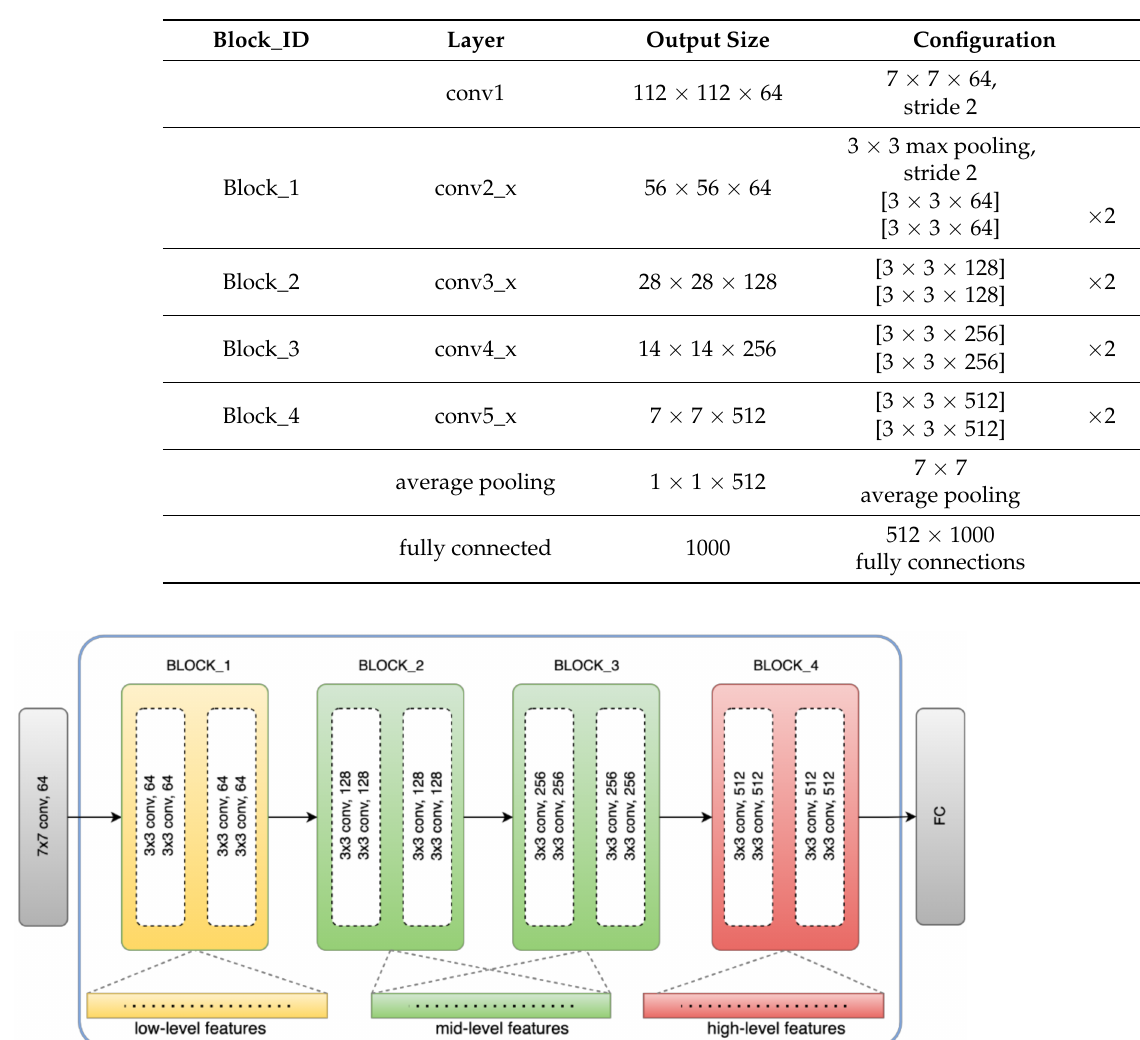
Figure 3. Identity residual block of ResNet18. Table 1. ResNet18 network structure.